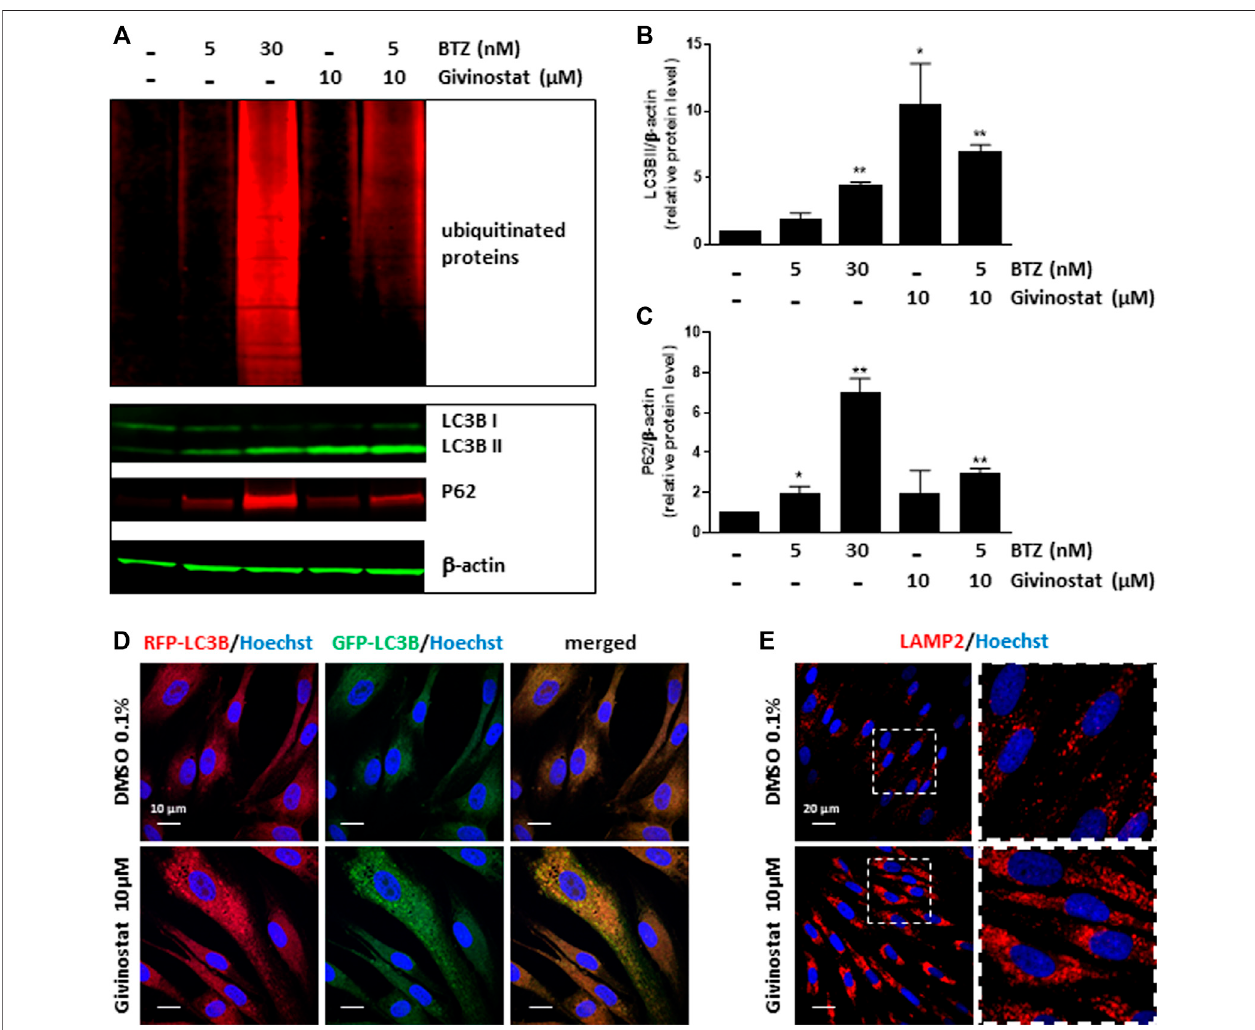
FIGURE6| Givinostatinhibitstheautophagypathway. (A) Immunoblotanalysisofubiquitinatedproteins(upperpannel),LC3BI/IIandP62(lowerpanel)expression in fi broblastsoverexpressingR77C- α -SGmChandtreatedwithDMSO(0.1%),BTZ(5and30 nM)orgivinostat(10 μ M)inabsenceorinpresenceof5 nMBTZfor24 h β - actinwasusedtoevaluatetheloading. (B,C) Quanti fi cationofLC3BII (B) andP62 (C) proteinexpression levels.Valuesareexpressed asrelativeproteinexpressionlevel to DMSO treated cells and normalized to β -actin. Data are mean ± SD of three independent experiments; * p ≤ 0.05, ** p ≤ 0.01 (Student ’ s t-test). (D) Fibroblasts transientlyexpressingGFP-RFP-LC3Bweretreatedwithgivinostat(10 μ M)orDMSO(0.1%)for24 handthecolocalizationofGFPandRFPpunctawasdetected.Nuclei are labelled by Hoechst staining (blue). Scale bar = 10 μ m (E) Confocal images of LAMP2 (red) and Hoechst staining (blue) after DMSO (0.1%) or givinostat (10 µM) treatments. Scale bar = 20 μ m. Insets are magni fi cations of the boxed